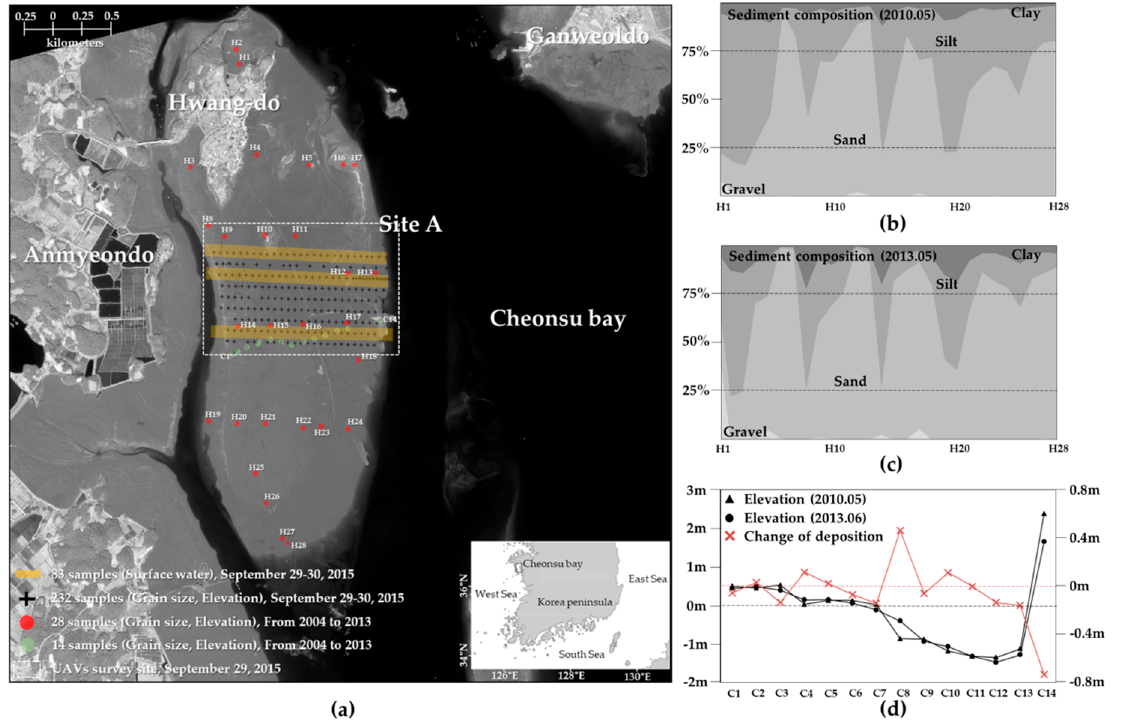
Figure 1. Kompsat-3 panchromatic image of the Cheonsu bay and Hwang-do tidal flat, acquired on March 23, 2015. ( a ) The square-dotted line delineates the study area (Site A), which is the unmanned aerial vehicle (UAV) survey site. The area is around 2.5 km 2 in size. The crosses and yellow boxes indicate the measurement sites for grain size, elevation, and surface water on September 29–30, 2015. The red and green circles are the measurement sites for grain size and elevation from 2004 to 2013. ( b , c ) show the sediment composition in May 2010 and May 2013 at the H sites. ( d ) Shows the change in elevation between May 2010 and June 2013. Erosion and sedimentation of sediment at the C sites can be seen.